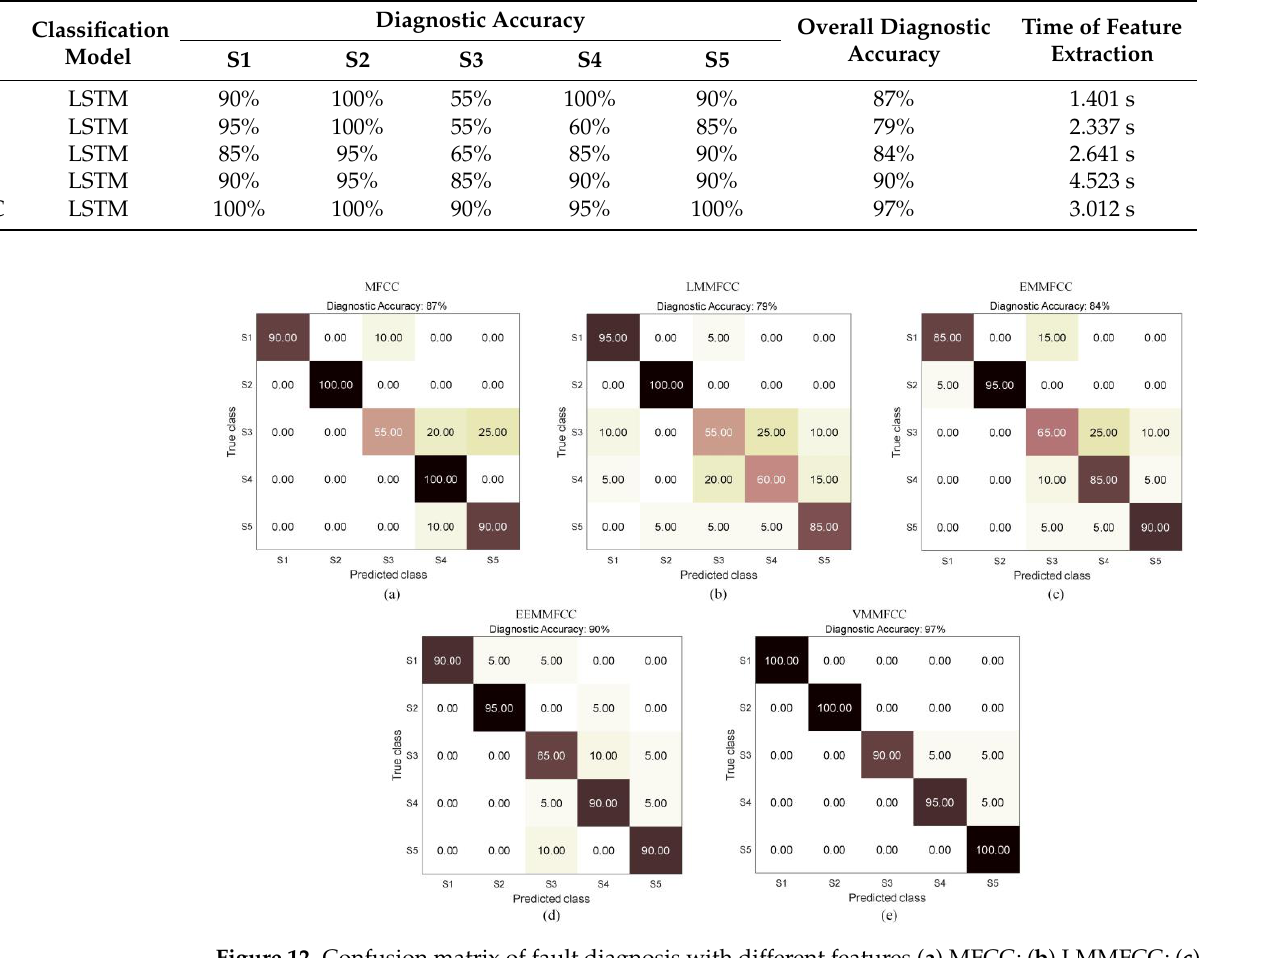
Figure 12. Confusion matrix of fault diagnosis with different features ( a ) MFCC; ( b ) LMMFCC; ( c ) EMMFCC; ( d ) EEMMFCC; ( e ) VMMFCC.